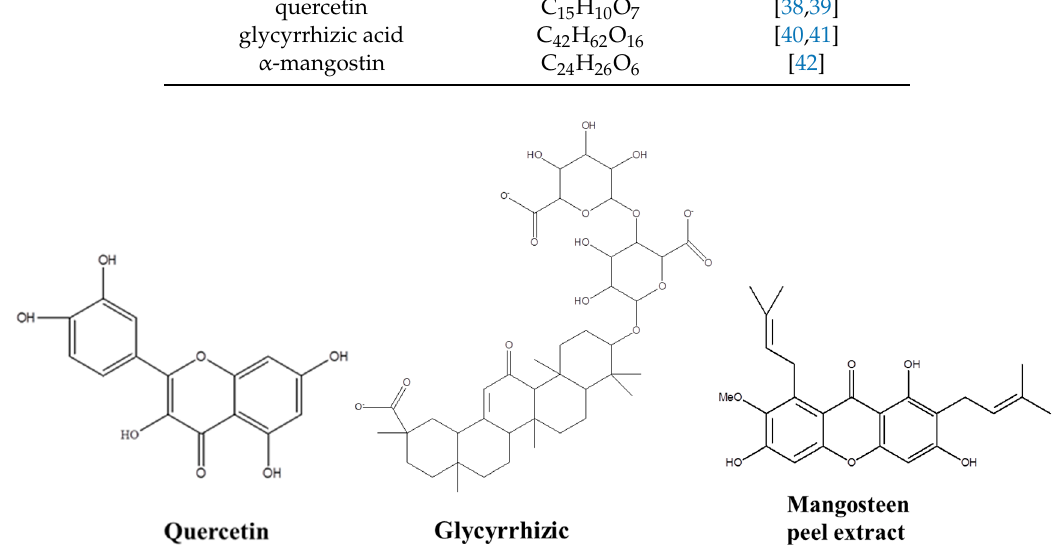
Table 9. The chemical formula of natural active molecules. Natural Active Molecules Chemical Formula